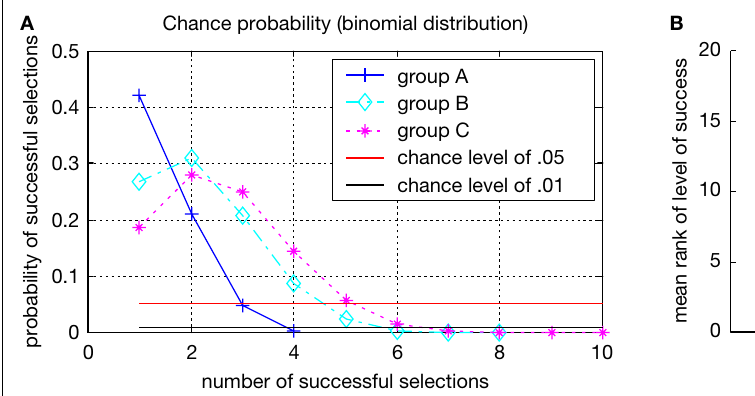
FIGURE 5 | (A) Chance probability of successful selection depending on the number of selections; with “group A” we refer to the four icons to be selected during testing day T4 (at least three successful selections to be above chance ); with “group B” we refer to the eight icons to be selected during follow-up test by one ALS patient (at least fi ve successful selections to be above chance ); with “group C” we refer to the 10 icons to be selected during follow-up test by the remaining four ALS patients (at least